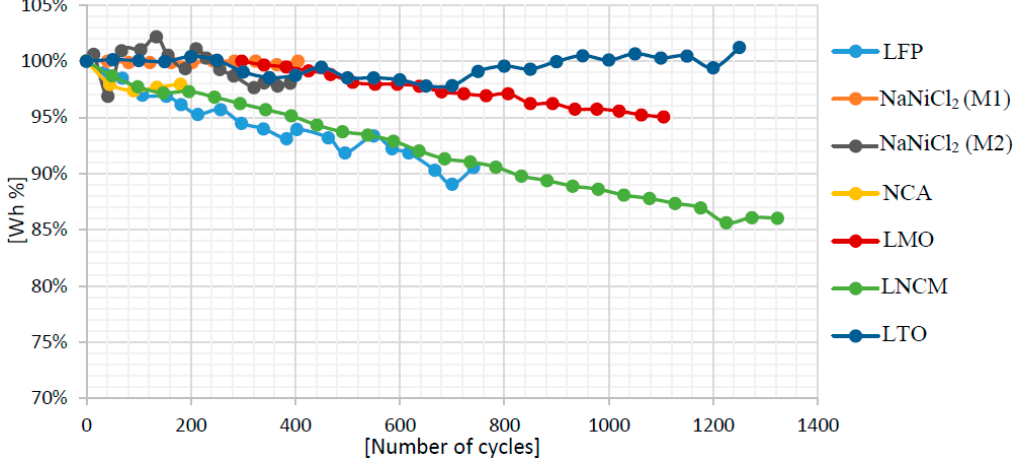
Figure 15. Comparative curves of ageing for different technologies based on the frequency regulation cycle.